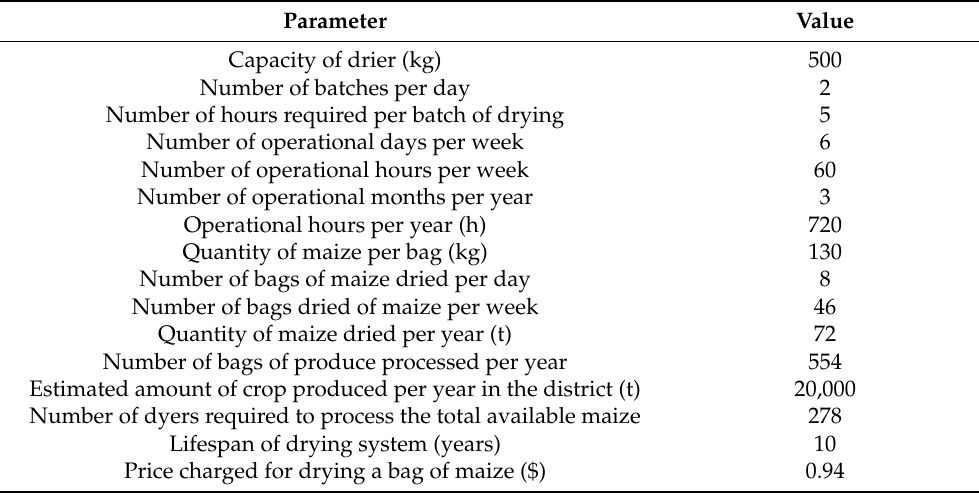
Table 2. Technical and financial parameters considered for the business model proposed in the study.